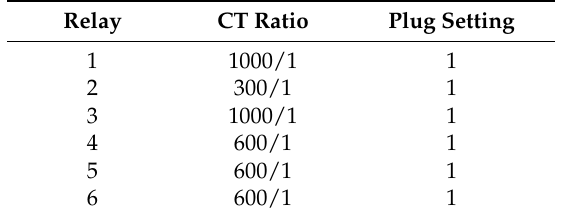
Table 15. CT ratios and plug settings of the relays for Case IV.